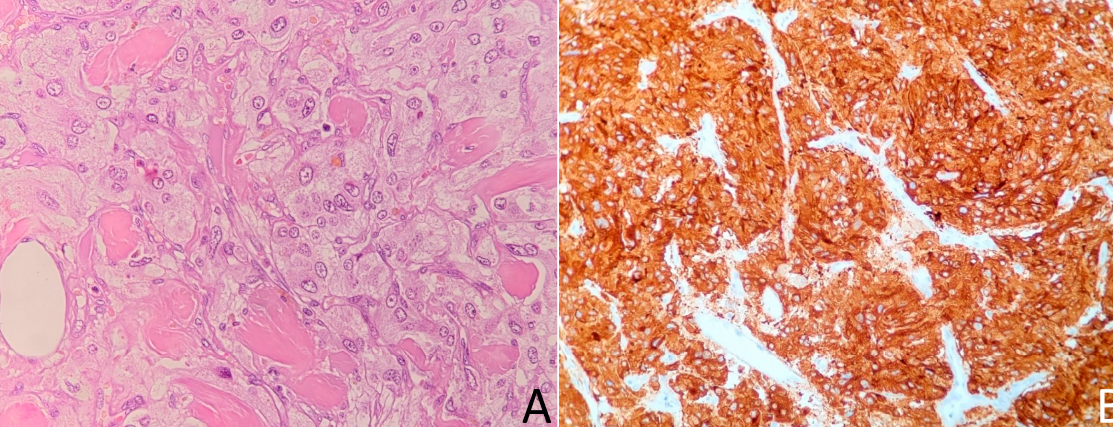
Figure 4. Pheochromocytoma—cells with moderate nuclear pleomorphism, prominent nucleoli, and abundant granular cytoplasm that form irregular nests. Hematoxylin & eosin, 400× magnification ( A ). Pheochromocytoma cells show strong cytoplasmic immunoreactivity for synaptophysin. 200× magnification ( B ).